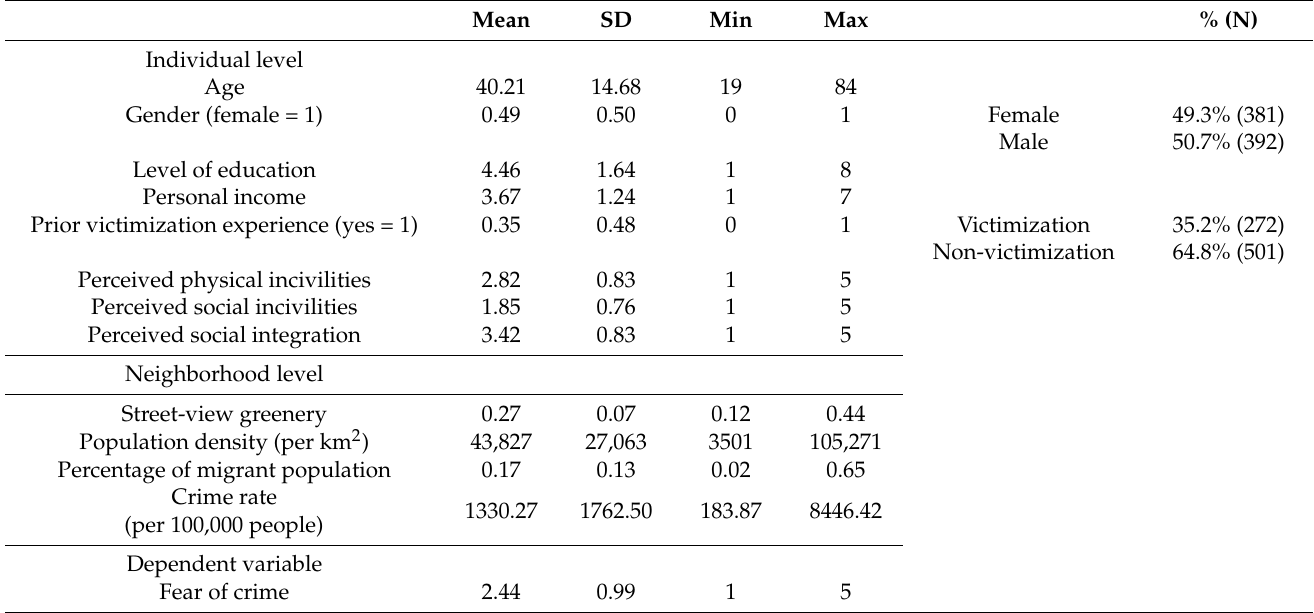
Table 1. The characteristics of the study variables.